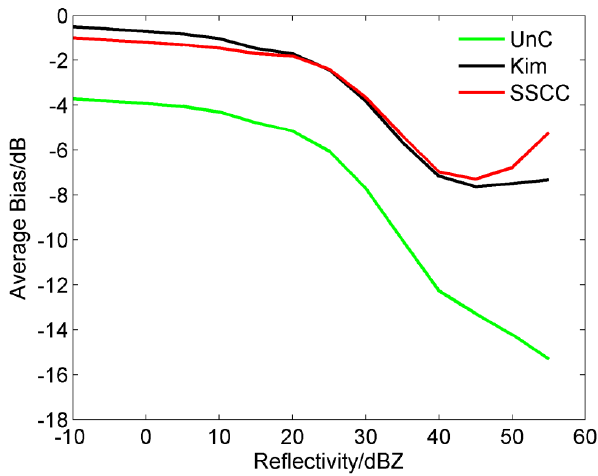
Figure 19. Average bias of reflectivity for the stratiform rain with embedded convection.